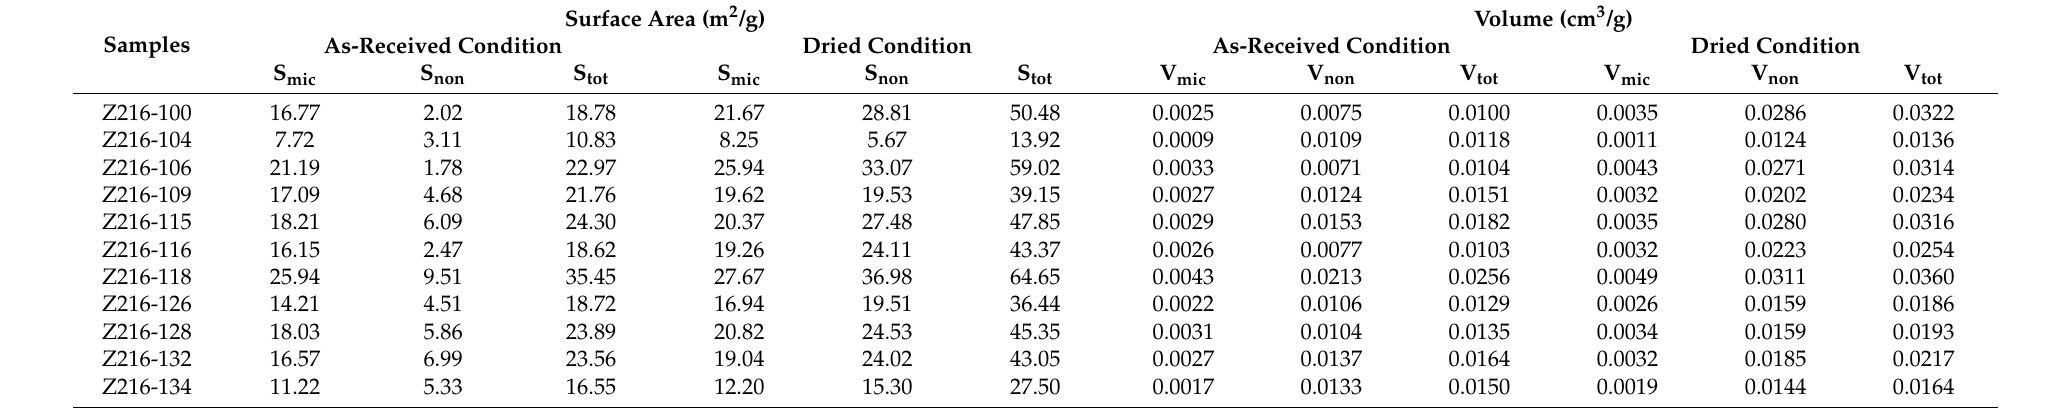
Table 3. Pore structure characteristics of the studied deep shale samples under as-received and dried